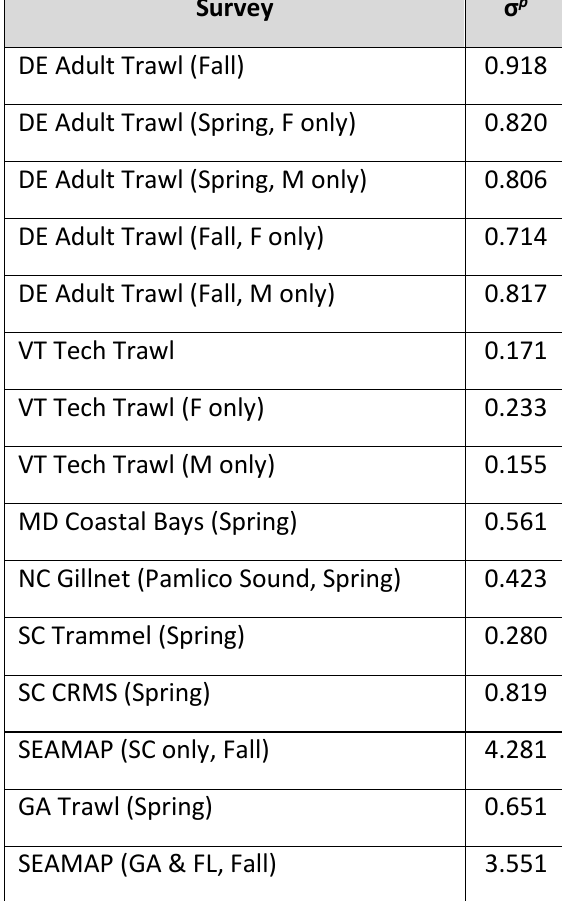
Table 37. List of surveys used in the regional Conn indices and their associated sigma values, or the standard deviation of the process error. All surveys are for combined sexes and adult horseshoe crabs unless specified in the